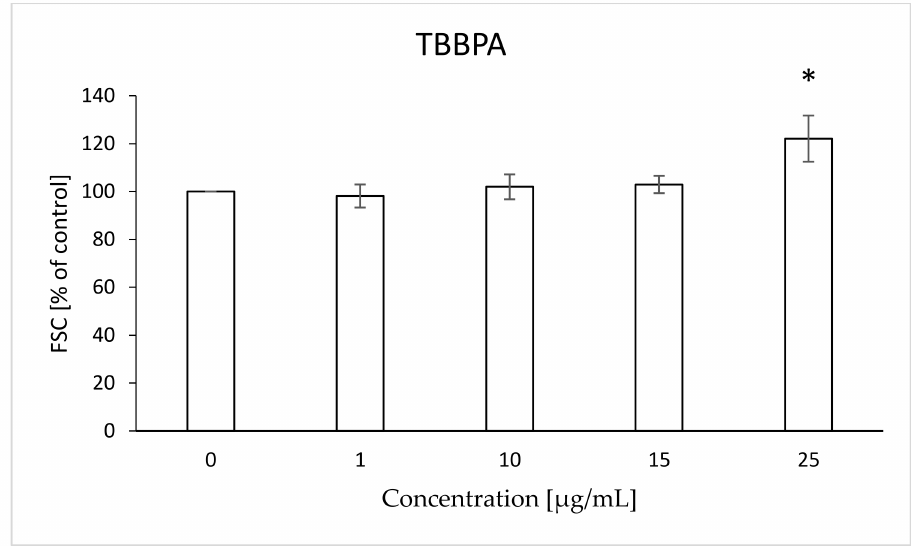
Figure 13. Changes in the FSC parameter in human control erythrocytes and the erythrocytes incubated with TBBPA at 1 to 25 µ g/mL for 48 h. (*) Significantly different from control ( p < 0.05).